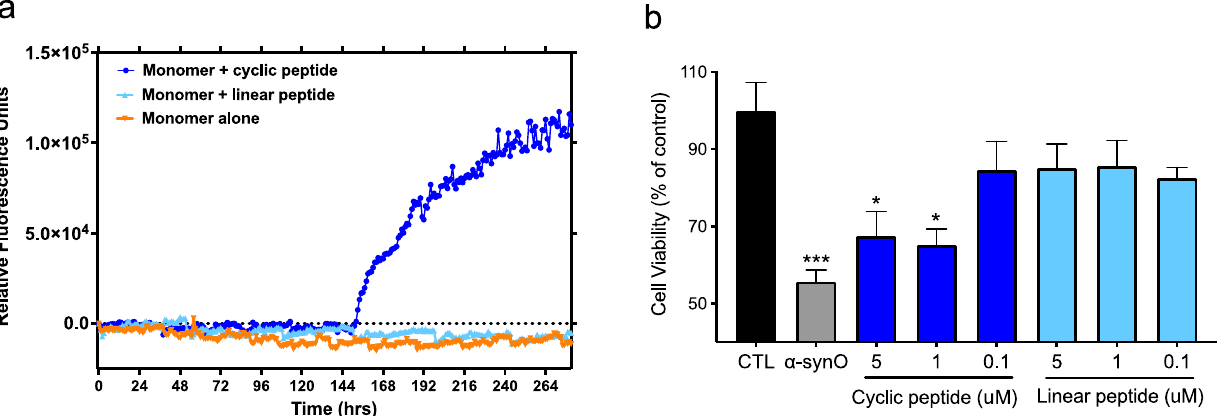
Figure 2. Conformational cyclic peptide epitopes have seeding activity and toxicity. ( a ) Aggregation was tracked hourly (shaking for 30 s prior to each reading) with a ThT fluorescent assay after the addition of α -syn monomers alone (100 mM) or in the presence of BSA-conjugated cyclized or linear CGTKEQGGGG peptide (100 nM). Data are representative of 3 independent experiments. ( b ) Viability of primary rat dopaminergic neurons treated with α -syn oligomers (0.5 µM) or increasing concentrations of BSA-conjugated cyclized or linear peptide. CTL = neurons incubated with vehicle alone. Mean ± SEM of 6 replicates. Global analysis of data performed using one-way ANOVA followed by Dunnett’s multiple comparisons test. * p ≤ 0.05, *** p ≤ 0.001 vs. CTL (vehicle). No statistically significant difference between linear peptide and CTL or between α -syn oligomers and 1, 5 µM cyclic peptide.